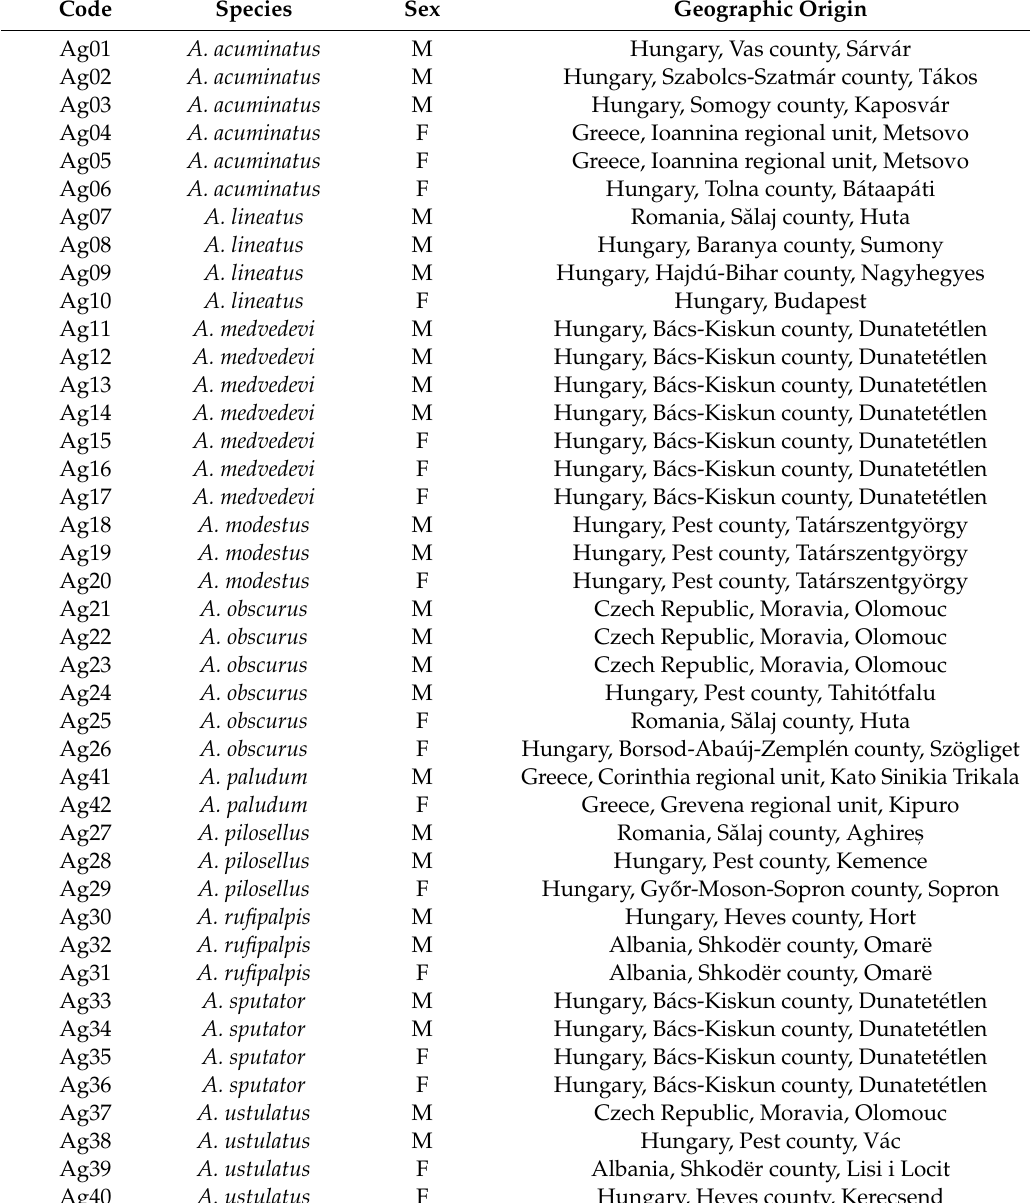
Table 1. List of Agriotes material used for the SEM study. M, male; F, female. Code Species Geographic